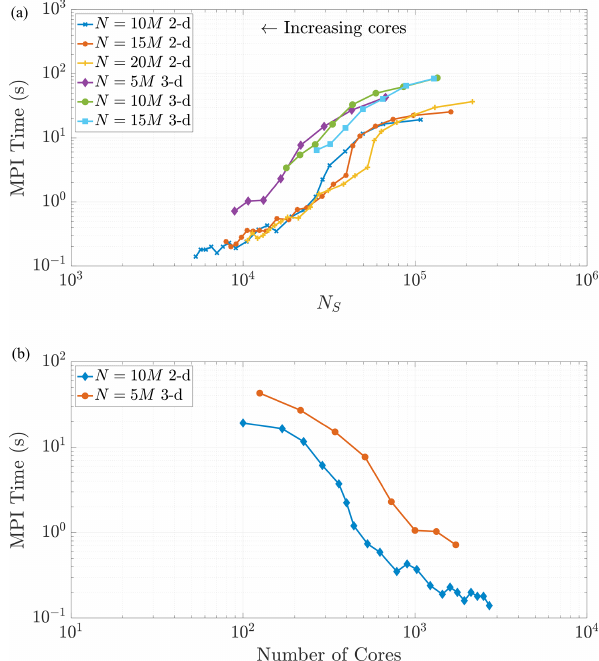
Figure 10. As N S decreases, we observe similar trends in the MPI subroutine run time in both 2-D and 3-D. Given that necessary communication takes places between 26 neighboring regions in 3- D rather than only eight neighboring regions in 2-D, the 3-D MPI times are, in general, 5 to 10 times slower than similar runs in